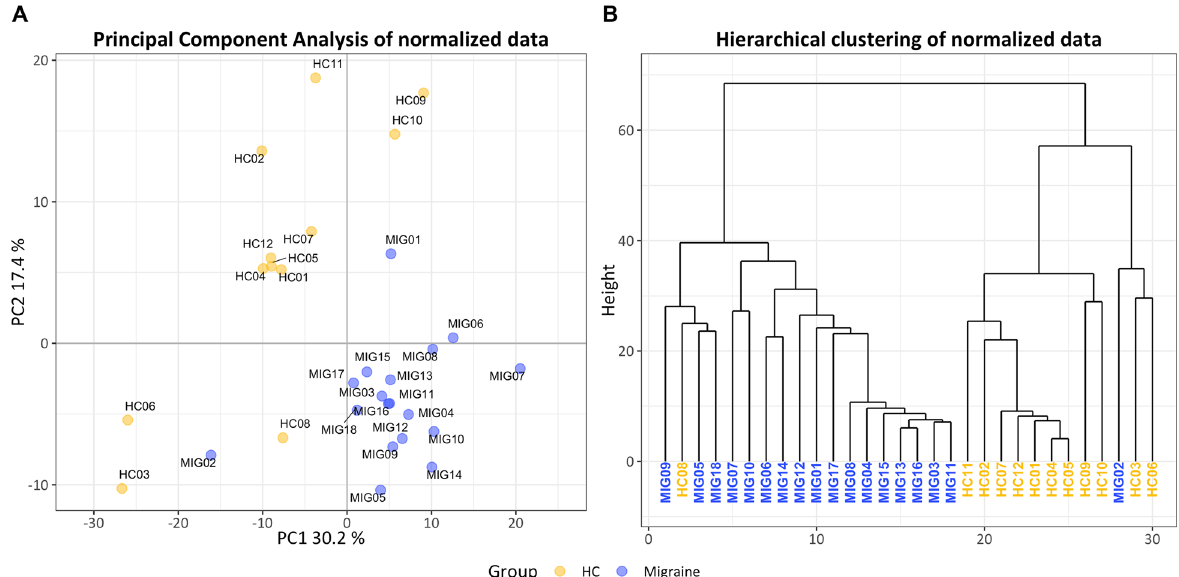
Fig. 2 Principal component analysis ( A ) and unsupervised hierarchical clustering ( B ) of miRNA normalized expression data. Unsupervised hierarchical clustering ( B ) was computed through euclidian distances between samples. HC: healthy controls; MIG: patients with migraine, PC: principal component